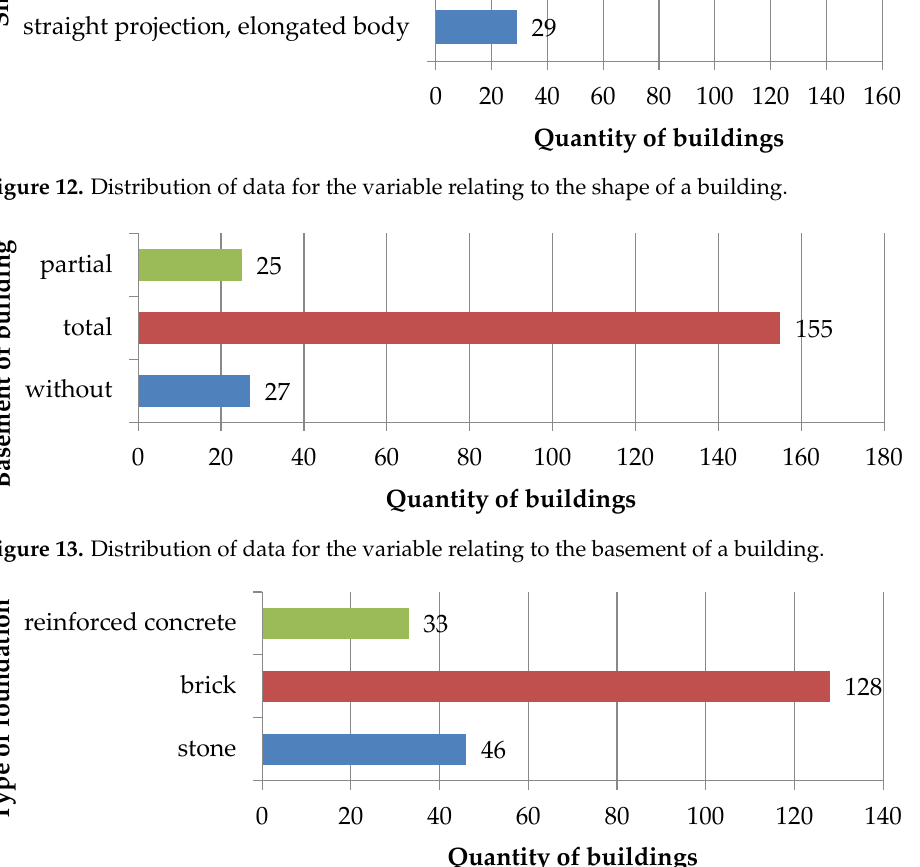
Figure 15. Distribution of data for the variable relating to the basement’s wall materials. Figure 16. Distribution of data for the variable relating to the ceiling above the basement.